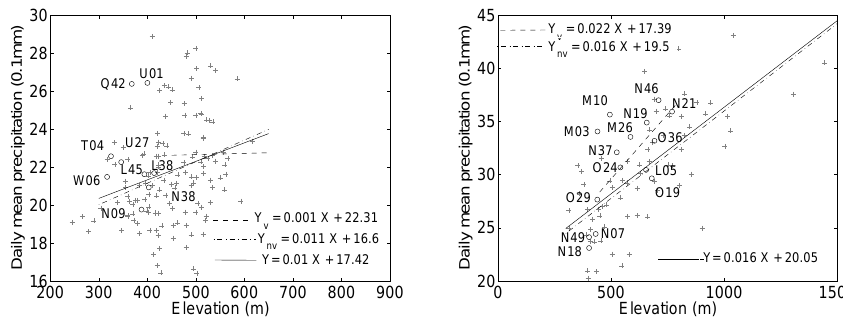
Fig. 11. Location of outliers and local scatter plot with trendlines (circles indicate valley stations, and crosses indicate non-valley stations, the trendlines are also shown in the figure.). Table 4. Statistical test results of station group in